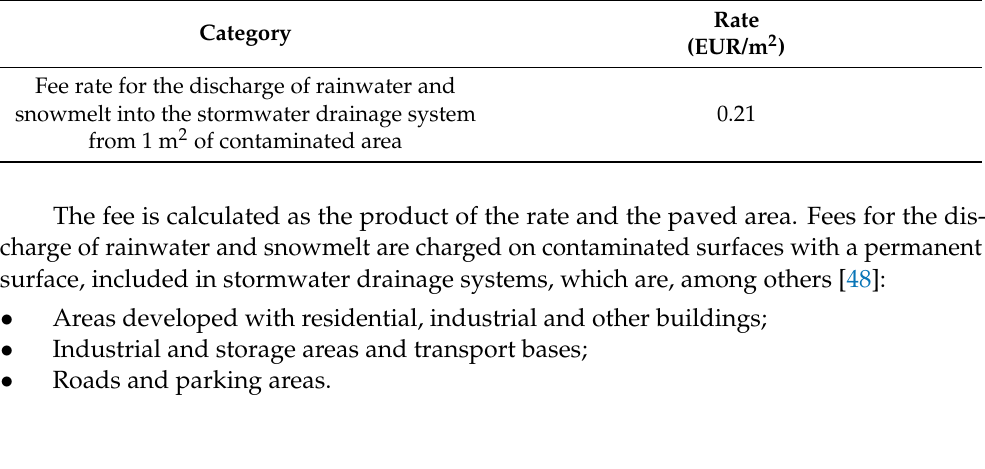
Table 5. Rate of fee for discharge of rainwater into the sewer system in Trzcianka [48].